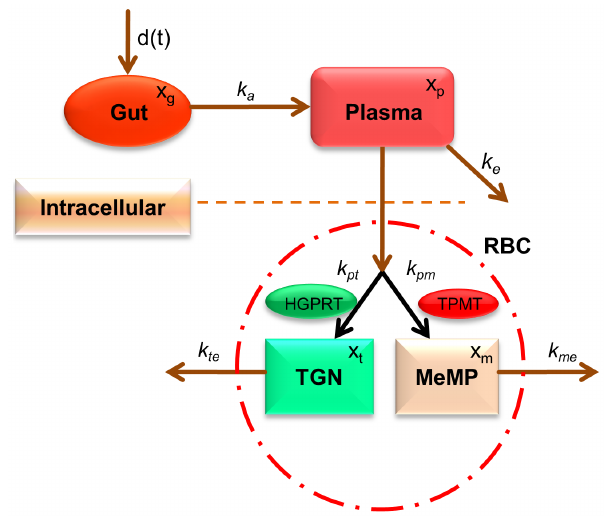
Figure 2. Schematic representation of 6-MP metabolism. Following oral intake to the gut, 6-MP is absorbed into the plasma from where it is eliminated through various routes. From plasma, 6-MP diffuses into the cells and enzymatically converted to 6-TGN and MeMP, which in turn are eliminated from the cells at a constant rate.